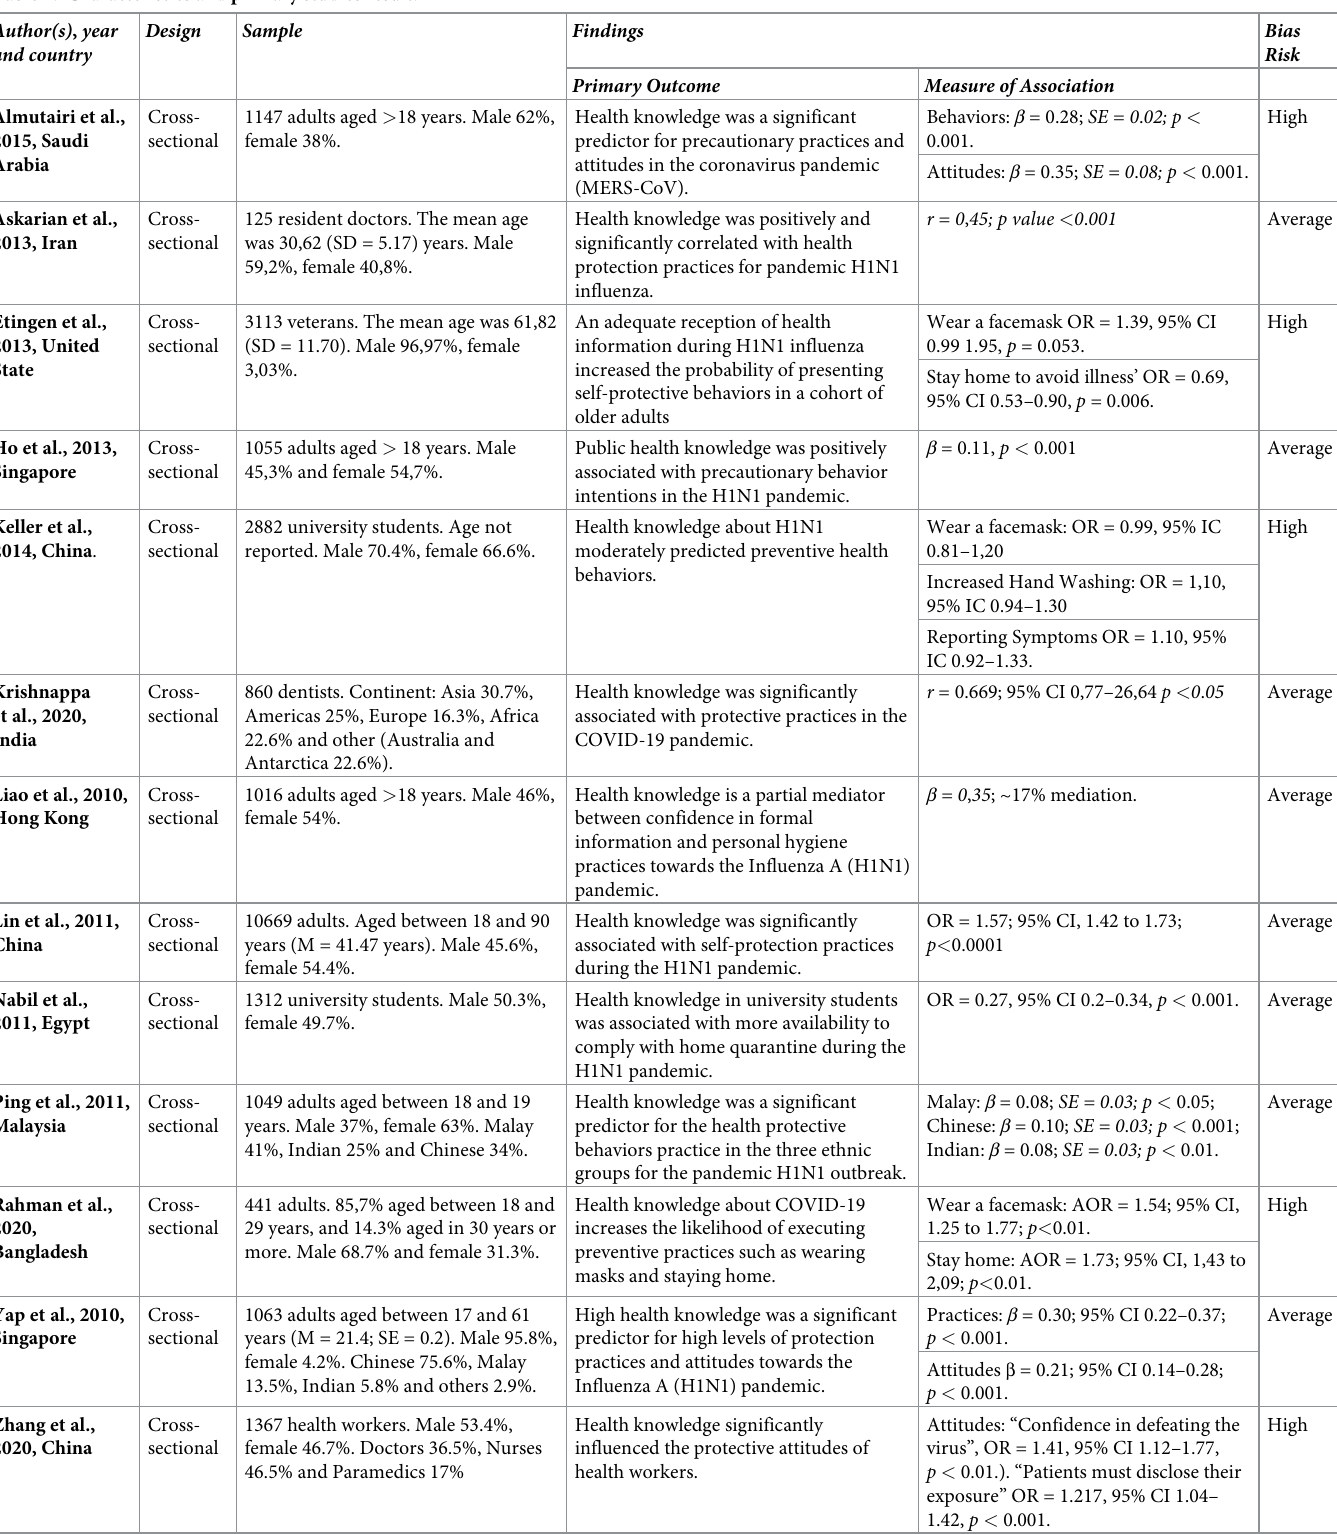
Table 1. Characteristics and primary studies